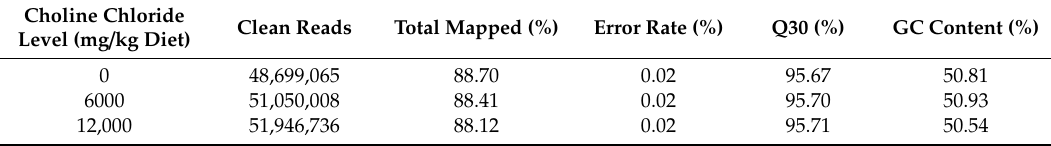
Table 6. Summary of the sequencing quality of L. vannamei given different levels of dietary choline chloride. Choline Chloride Level (mg / kg